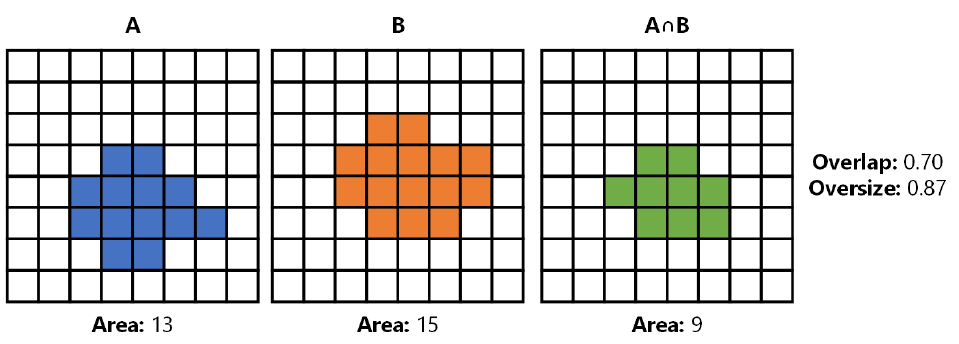
Figure 8. Exemplary cluster correspondence result between two